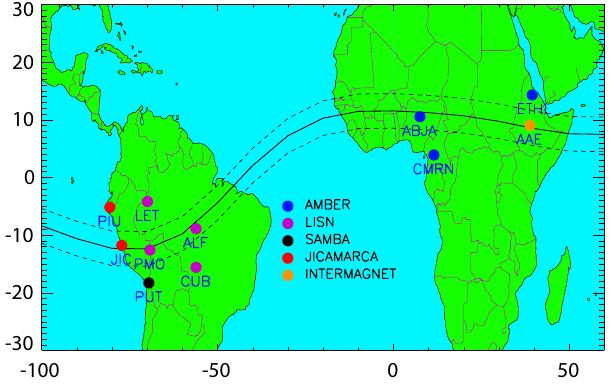
Fig. 1. Geographic location of the ground-based magnetometers used for this study. The solid horizontal line depicts the geomag- netic equator, and the two dashed lines indicate the EEJ region.